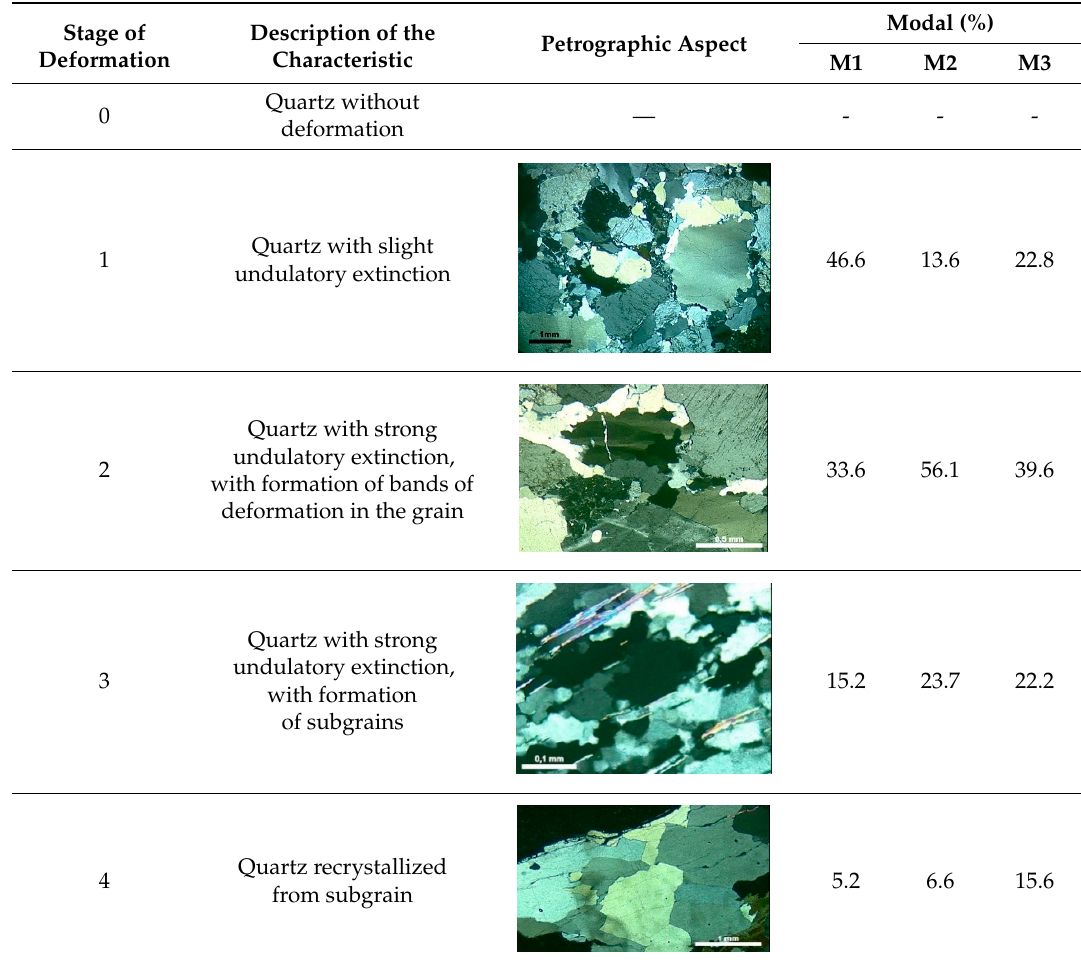
Table 2. Percentage amount of quartz in different stages of deformation present in the M1, M2, and M3 samples.